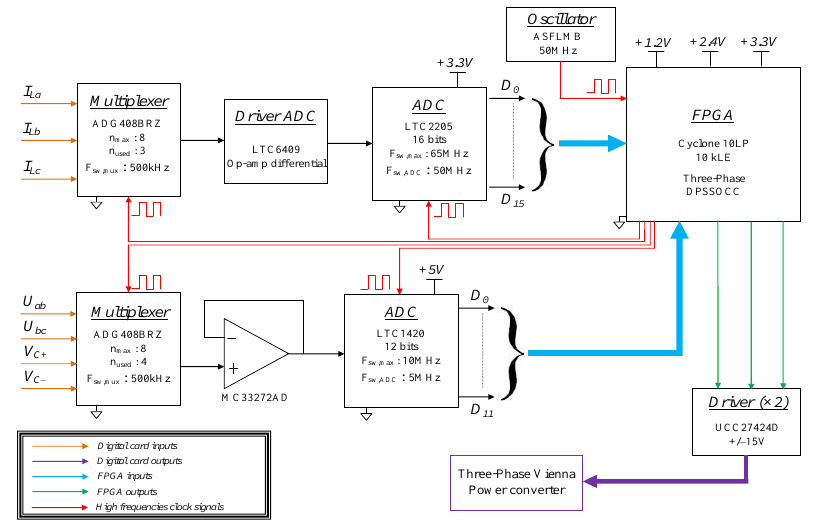
Figure 18. Synoptic of the signal processing chain of the digital card. The three-phase Vienna converter card is designed with three VUM 25-05e units (IXYS, Milpitas, CA, USA). The current references are provided thanks to a synchronization card.